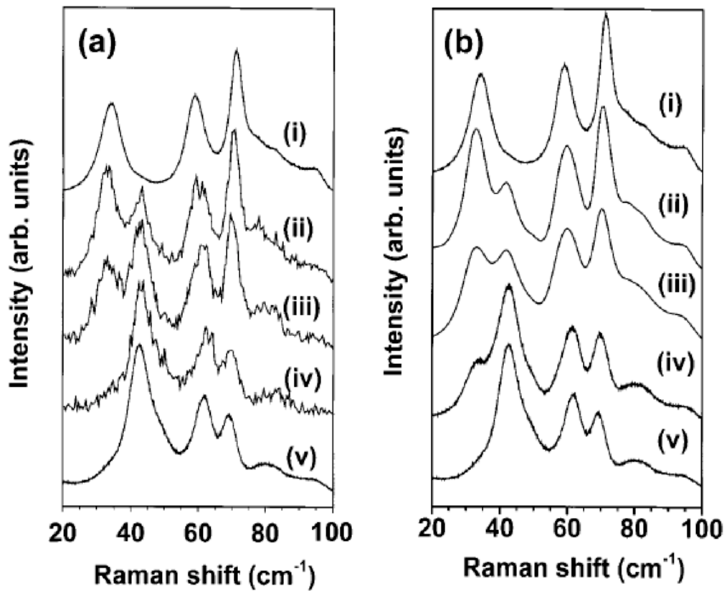
Figure 3. ( a ) Raman spectra of WO 3 powder samples that were mechanically pressed for various time periods: (i) starting virgin powder ( γ -phase); (ii) after 5 s compression; (iii) after 10 s com- pression; (iv) after 120 s compression; (v) reference treated powder sample, after 10 min moderate milling ( δ -phase). Note the strong rearrangement of the low-frequency spectra after the early steps of pressure application. ( b ) Low-frequency Raman spectra collected at RT on WO 3 virgin powder rapidly cooled by immersion in liquid nitrogen and kept there for different time periods: (i) starting virgin powder; (ii) after 5 s immersion in LN 2 ; (iii) 1 min immersion; (iv) 10 min immersion; (v) 2 h immersion. The varying intensity ratio between the peaks at 34 and 43 cm − 1 is clearly visible. Re-